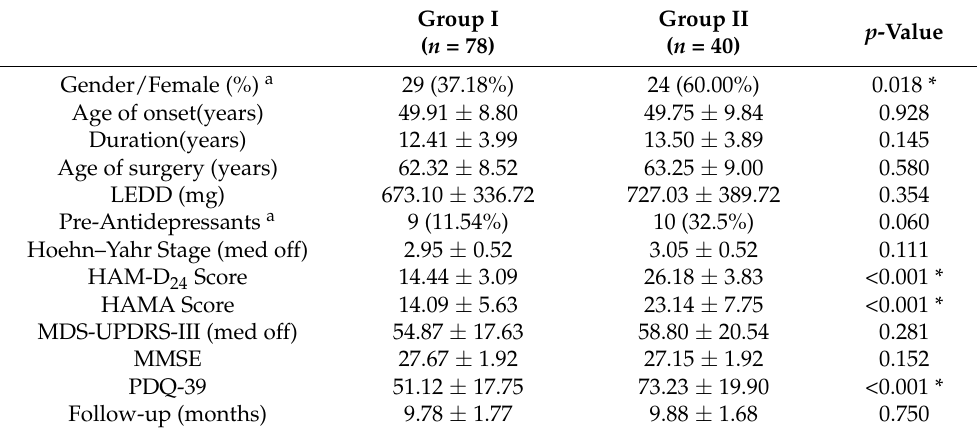
Table 1. Preoperative baseline characteristics of patients in Group I and Group